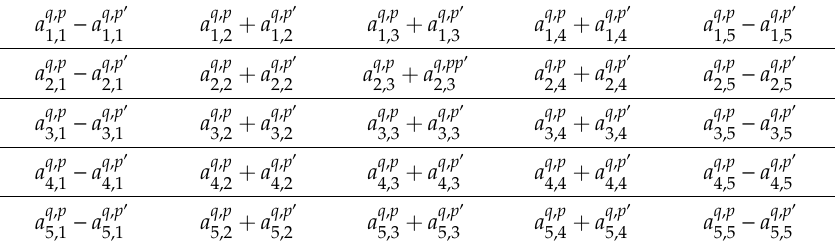
Table 1. Added mass coe ffi cients of the q floater, q = 1, ... , N , in front of a vertical wall, using